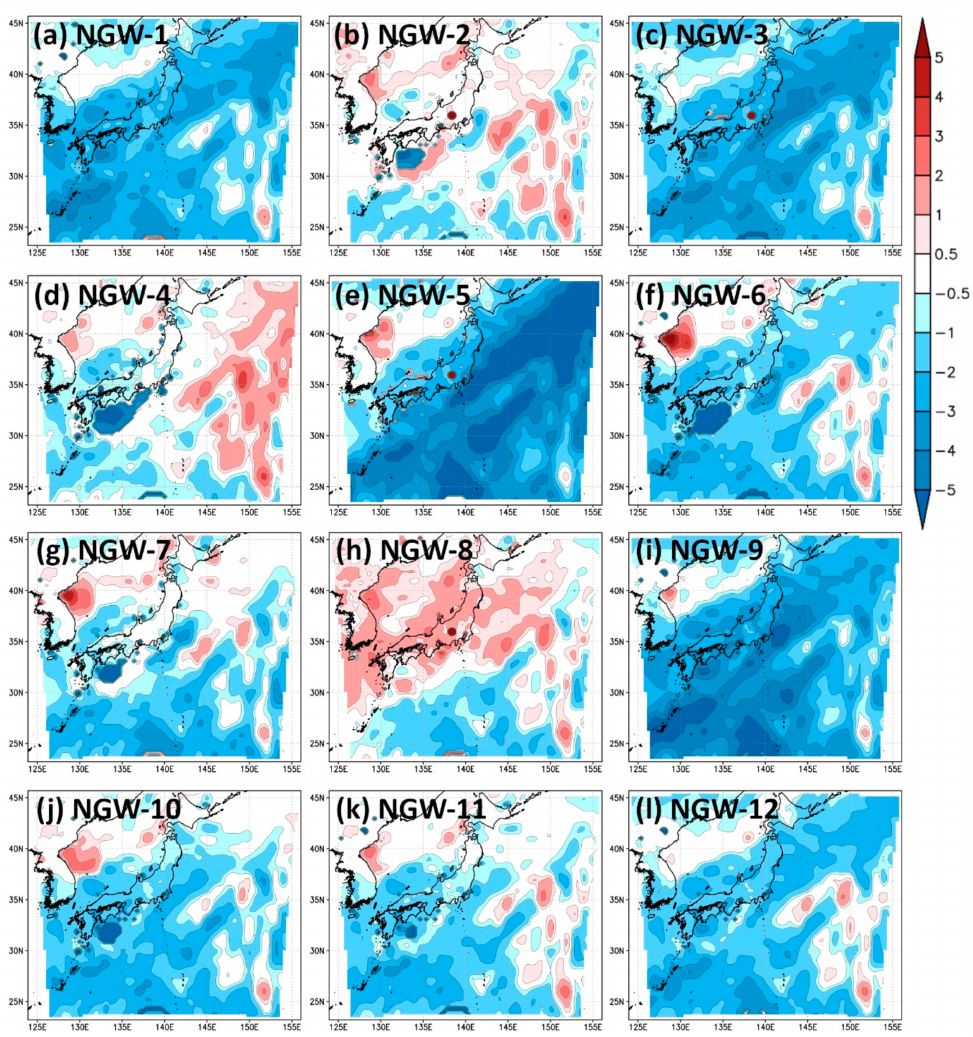
Figure 13. Di ff erence in precipitable water content (PWC) under initial conditions between each NGW simulation and the hindcast. Result ( a ) NGW-1, ( b ) NGW-2, ( c ) NGW-3, ( d ) NGW-4, ( e ) NGW-5, ( f ) NGW-6, ( g ) NGW-7, ( h ) NGW-8, ( i ) NGW-9, ( j ) NGW-10, ( k ) NGW-11, ( l ) NGW-12. The unit of the color bar is